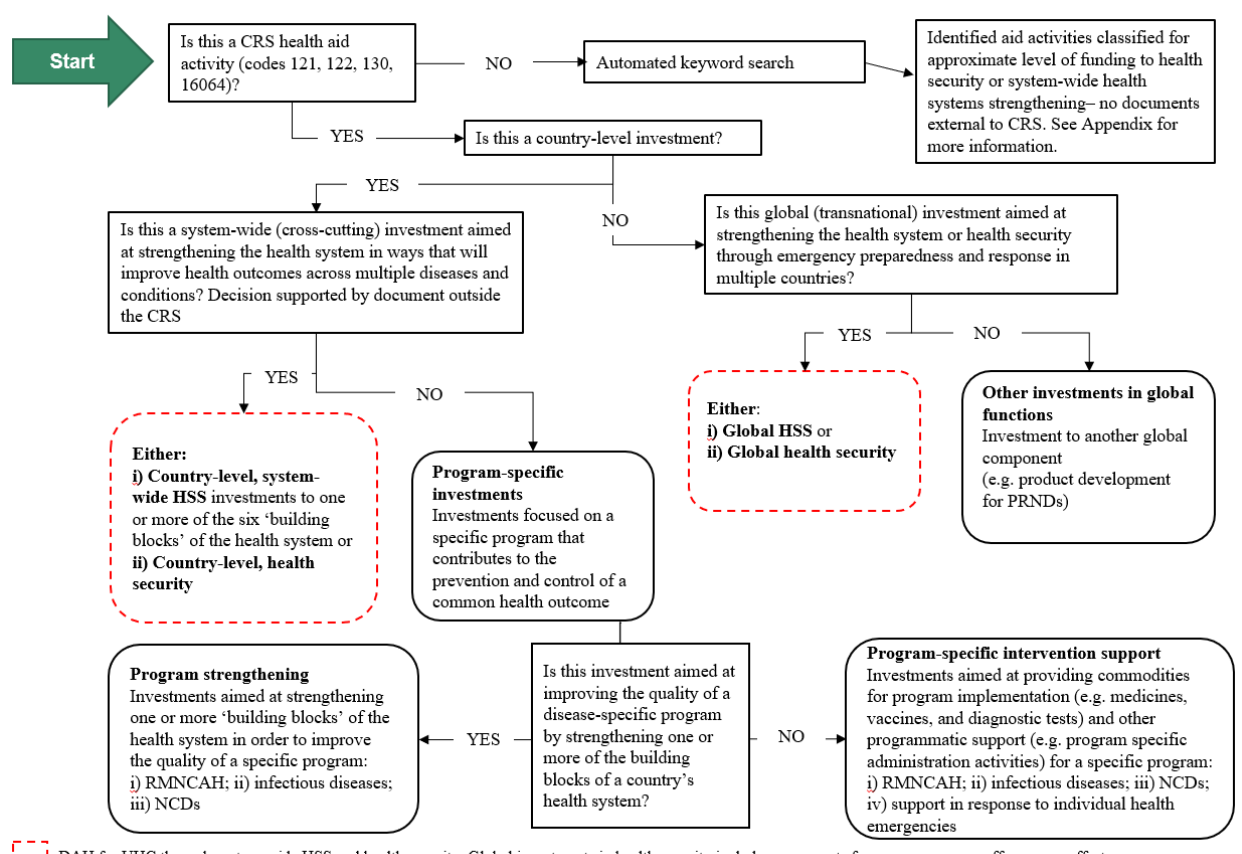
Figure 2. Decision tree that guided the coding of DAH. DAH, development assistance for health; CRS, Creditor Reporting System; HSS, health systems strengthening; PRNDs, poverty-related and neglected diseases; RMNCAH, reproductive, maternal, newborn child and adolescent health; NCD, non-communicable